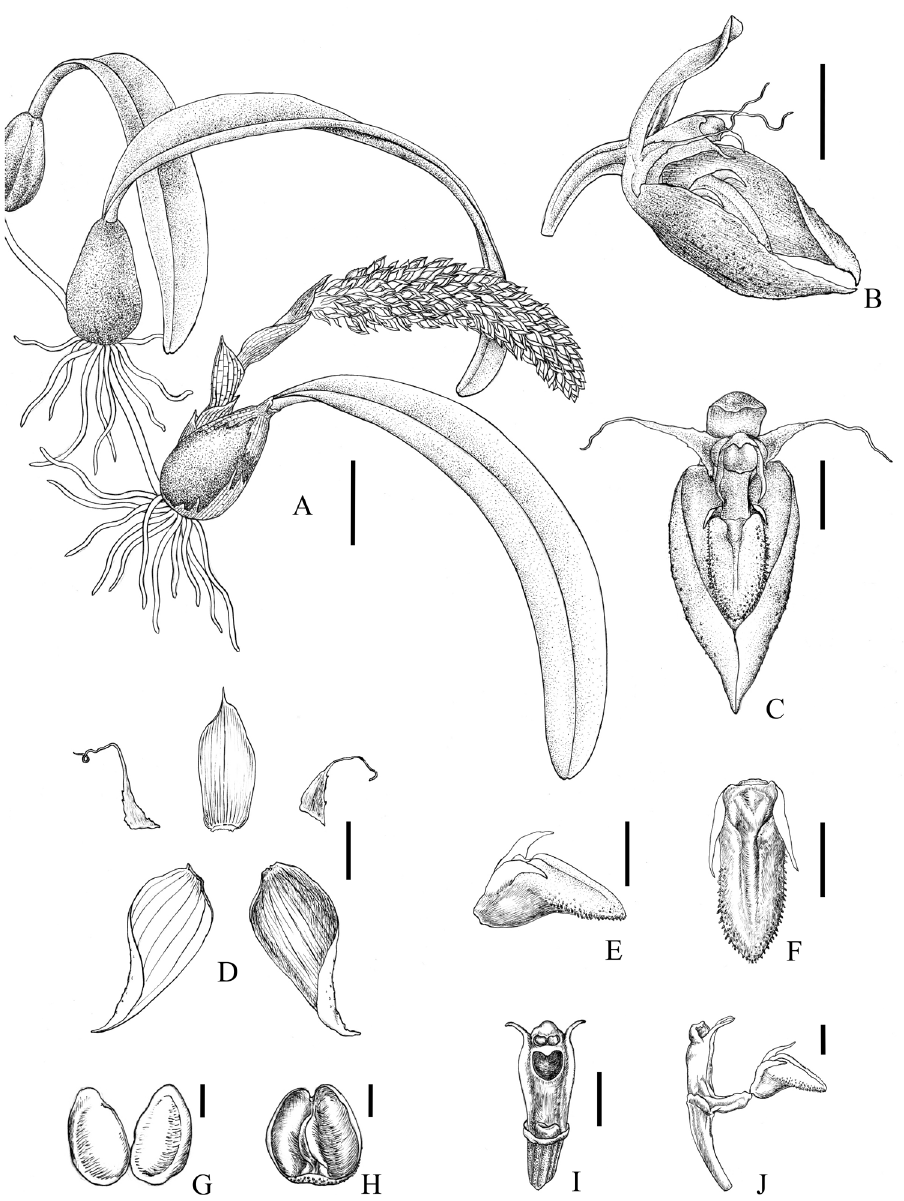
Figure 1. Bulbophyllum chrysolabium. A Habit B Flower, lateral view C Flower, frontal view D Dorsal se- pal, petals and lateral sepals, adaxial view E Lip, lateral view F Lip, ventral view G Pollinia H Operculum, ventral view I Column, ventral view J Column and lip, lateral view. Scale bars: 2 cm ( A ), 2 mm ( B–D ), 1 mm ( E–F, I–J ), 0.2 mm ( G–H ). Drawn by Yun-Xiao